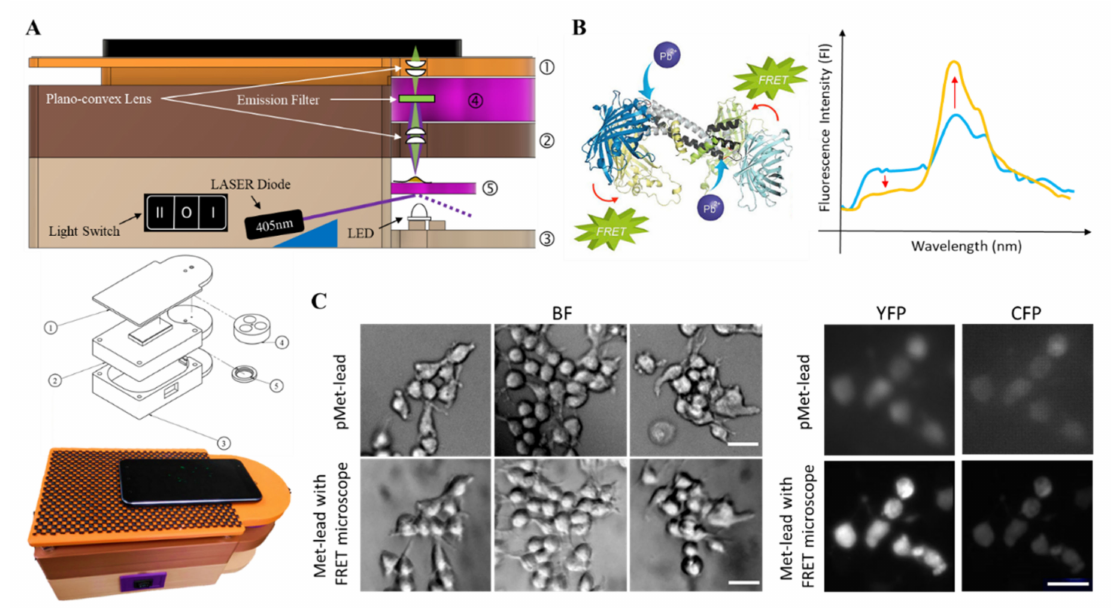
Figure 1. Design and layout of the portable FRET-based Pb-sensing device (pMet-lead), and examples of images generated with pMet-lead compared to conventional FRET ratio imaging. ( A ) Side view (upper), exploded view (middle), and entity (bottom) of the optical design of the pMet-lead device to demonstrate the general setup of pMet-lead: (1) the top plate holds the smartphone; (2) the middle part of the apparatus contains the plano-convex lens and is linked to the filter turret (part 4); (3) the bottom part contains the illumination sources (LED for BF, LASER Diode for FL and light switch to turn off (O) or on to BF (I) or FL (II)), and is linked to the sample stage (part 5); (4) the filter turret contains two emission fluorescence filters that receive YFP and CFP emission signals (changeable according to various FRET pairs); (5) the sample stage receives the biochip containing the cells expressing the Met-lead biosensor. ( B ) Molecular structure design (left, originally from [8], and permission has been obtained to use the same here) and emission spectrum (right) of FRET-based Met-lead. ( C ) The representative bright-field (BF, left) and fluorescence (YFP, middle; CFP, right) images of the Pb-biosensor-expressing HEK293 cells obtained with pMet-lead (above) or under a FRET microscope (with 10 × objective; below). Scale bar, 30 µ